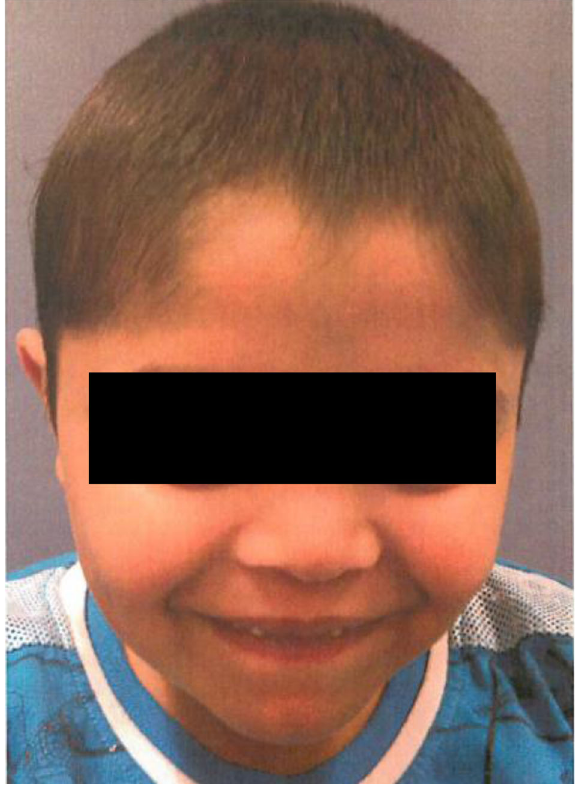
Fig. 4 Facial features of the patient 2. Narrow palpebral fi ssures, a long philtrum and a thin upper lip are evident, in keeping with the classical facial features of Roifman syndrome patients. Informed consent was obtained for publication of patient